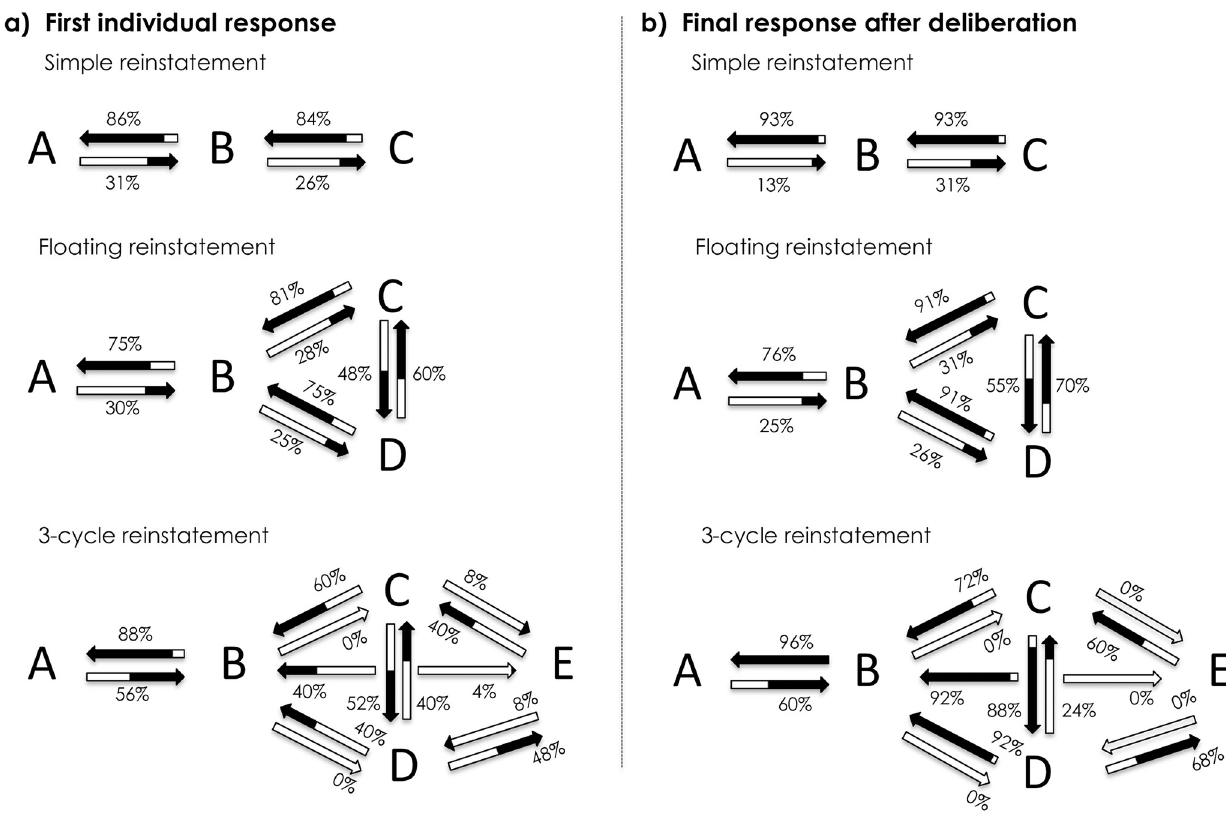
Fig 2. Graphical depiction of the relevant attacks between the arguments (displayed as a letter) from the three argumentation frameworks ( AFSimple , AFFloating , AF3-cycle , following Fig 1). Each directional arrow depicts one attack from an argument to another, and is filled as a function of the percentage of participants who drew the corresponding attack in their response sheet during A) the first personal response phase, and B) the final individual step after the group deliberation phase.